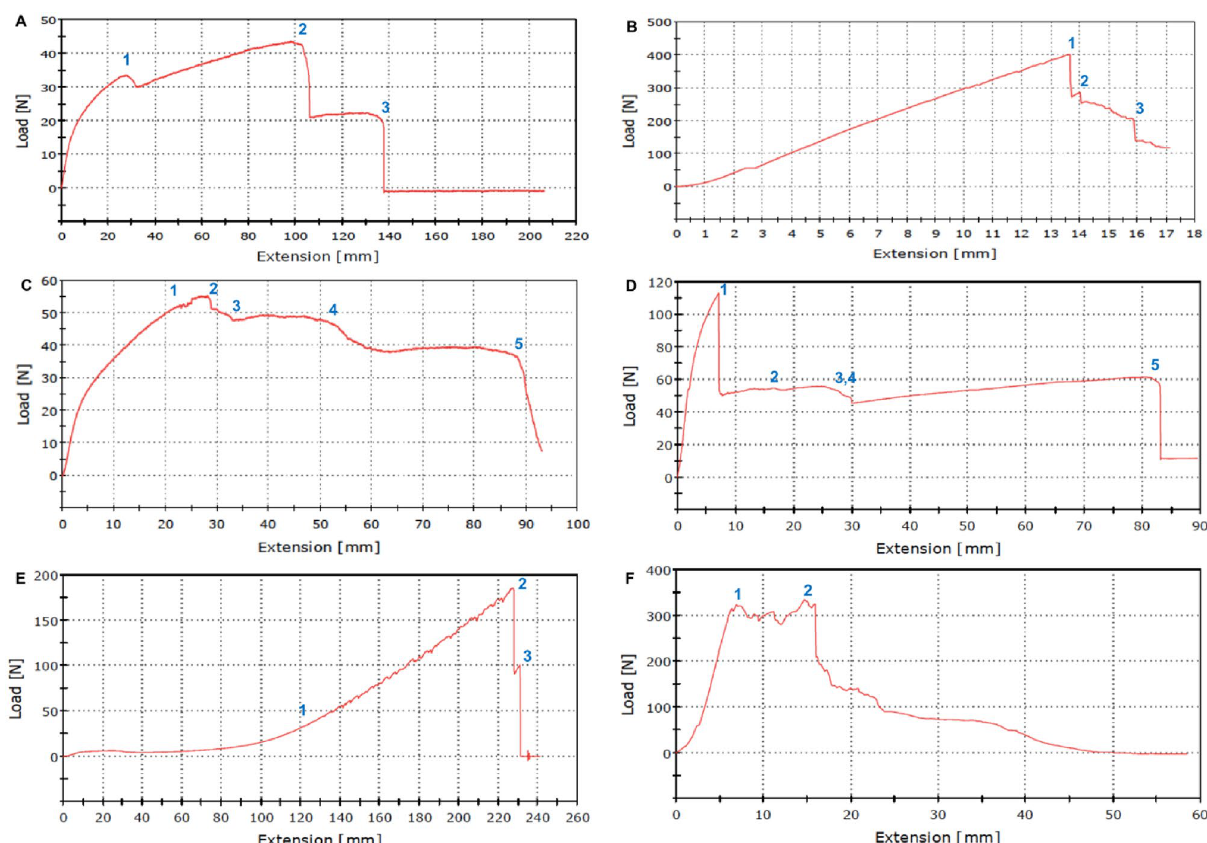
Figure 10. Strength test (stretch to failure) for multi-layered mask materials. Key: ( A ) surgical. ( B ) reusable cotton. ( C ) FFP2. ( D ) FFP3. ( E ) antiviral. ( F )